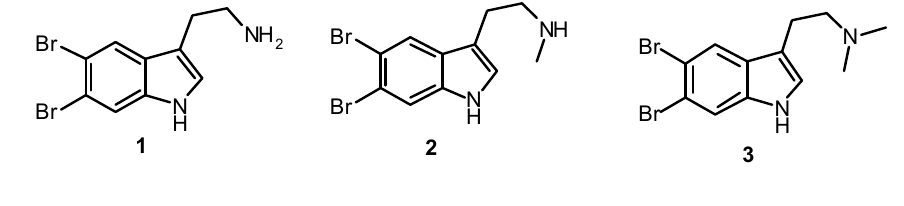
Figure 1. Chemical structures of isolated antibacterial metabolites from Hyrtios